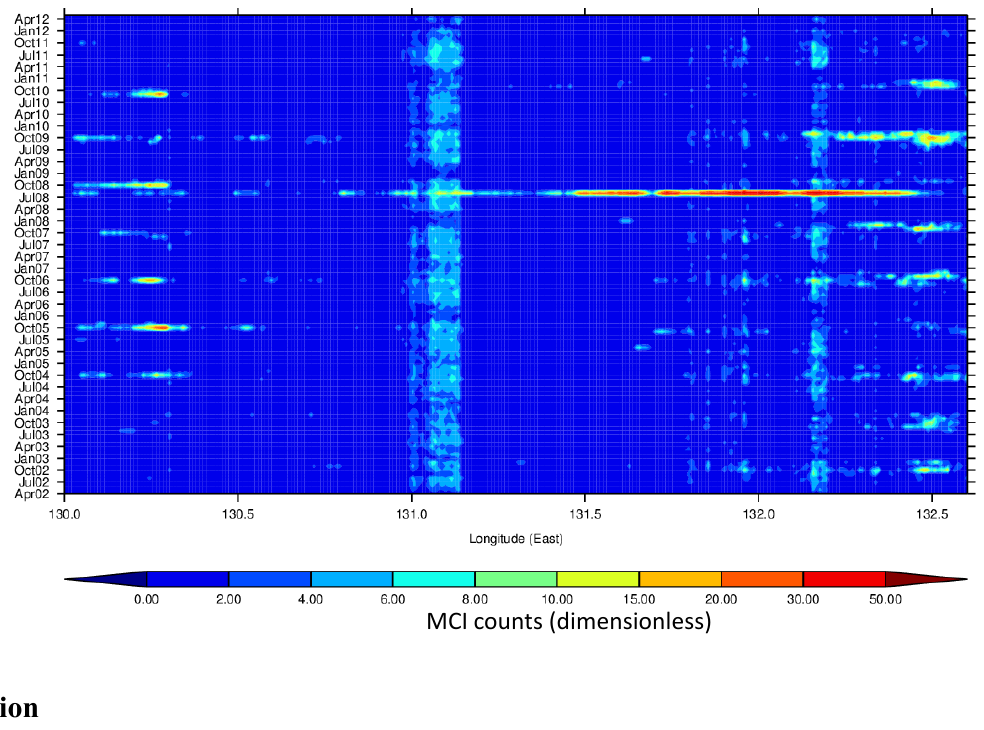
Figure 22. Longitude-time plot of MCI counts for the VDG